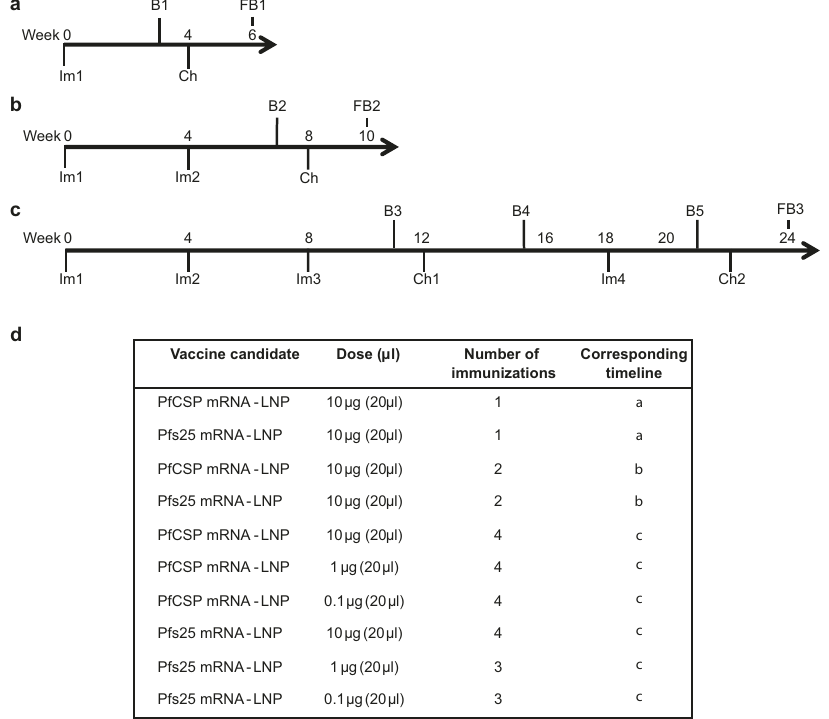
Fig. 6 Experimental details for immunization experiment to evaluate lower vaccine doses and repeat immunizations. Groups of female Balb/c mice were immunized with 10 μ g of either Pfs25 or PfCSP mRNA LNPs followed by a challenge with sporozoites after one ( a ), two ( b ), and three and four immunizations ( c ), as indicated. Two additional groups of mice for each mRNA-LNP were immunized with lower doses (0.1 μ g and 1 μ g) mRNA-LNPs to assess minimum immunogenic doses of Pfs25 or PfCSP mRNA-LNPs. B3 collected at 11 weeks from mice immunized with 0.1, 1.0 and 10.0 ug doses of Pfs25 mRNA-LNP were used in SMFA. Bleeds FB1 ( a ), FB2 ( b ) and B4 ( c ) were used in SMFA to evaluate transmission blocking activity in mice receiving one, two or three immunizations, respectively. d shows the immunization parameters corresponding to the timelines in ( a – c